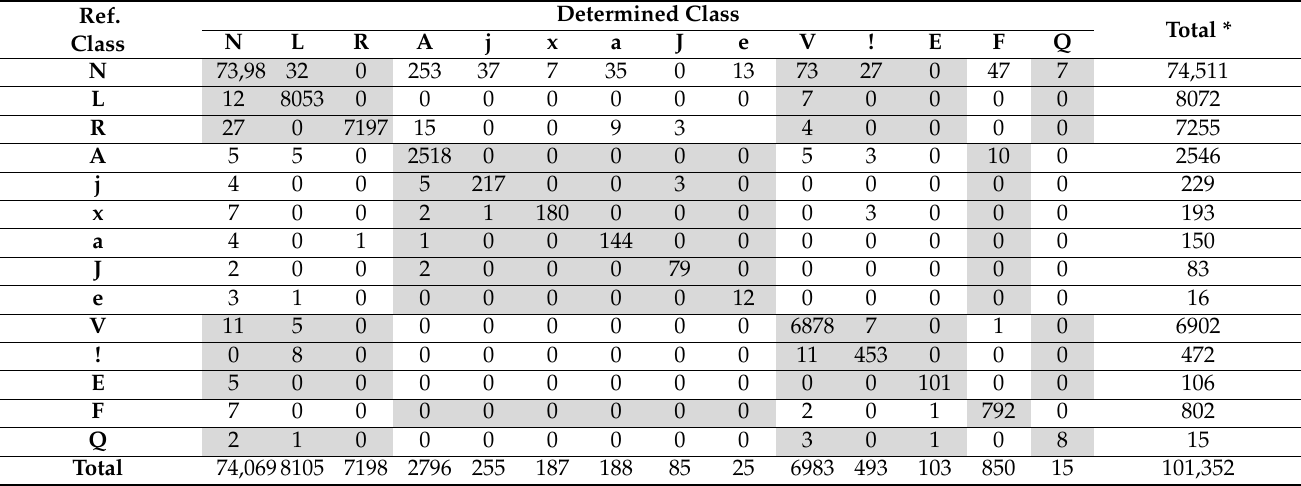
Table 4. Confusion matrix for beat classification using MITDB beat labels (with nECG MITDB records, labels concatenated accordingly to AAMI have the same background).